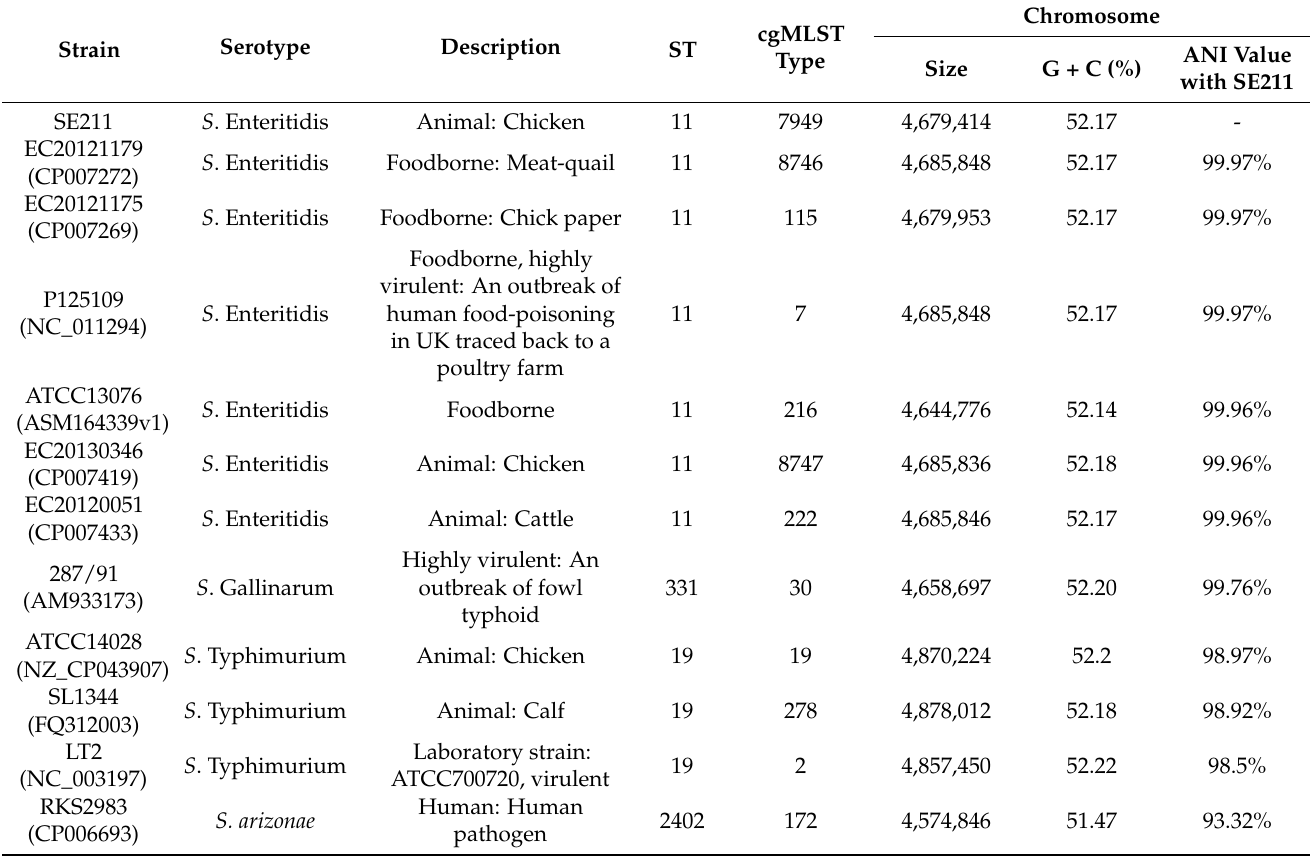
Table 2. Basic features of six S. enterica strains and ANI value between these strains with SE211.